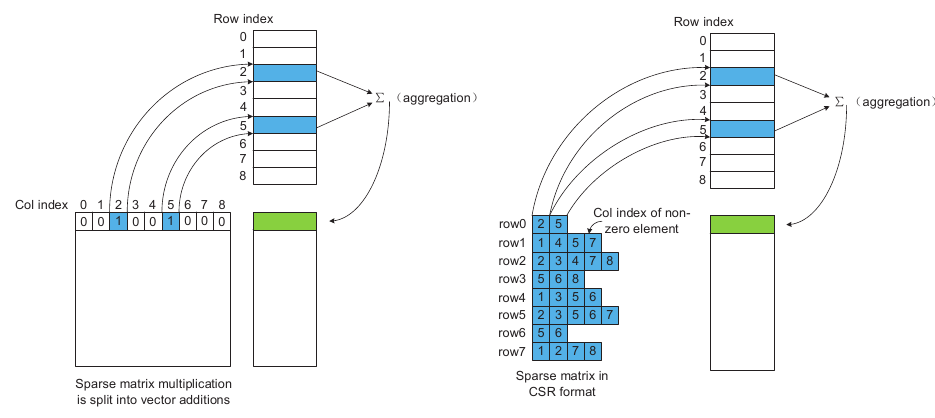
Figure 4. The computation process of a sparse